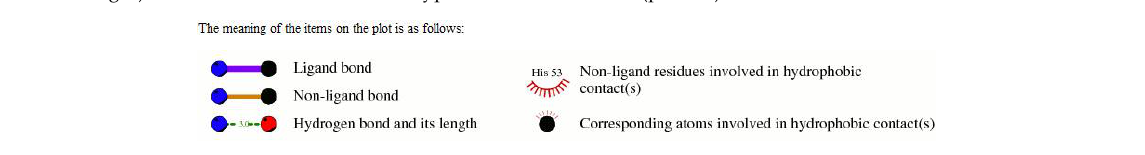
Figure 7: Protein-ligand interaction of Complex Trypanothione Reductase_9,12-Octadecadienoic acid (Z,Z)- Note: 9,12-Octadecadienoic acid (Z,Z)- (ligand) form one hydrogen bond (represented as green broken lines with bond length) with amino acid Ser464 of trypanothione reductase (protein).